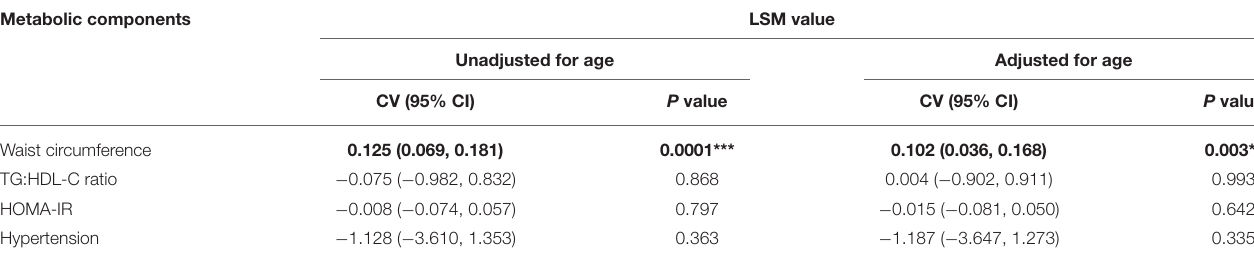
TABLE 3 | Metabolic components independently associated with liver fibrosis (LSM value) in overweight and obese children and adolescents. Metabolic components